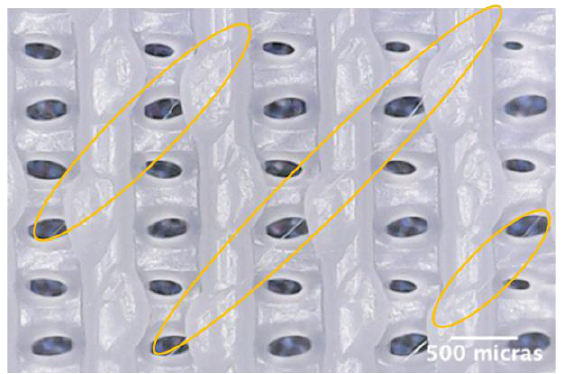
Figure 10. Microscopic images of experiment D1B.